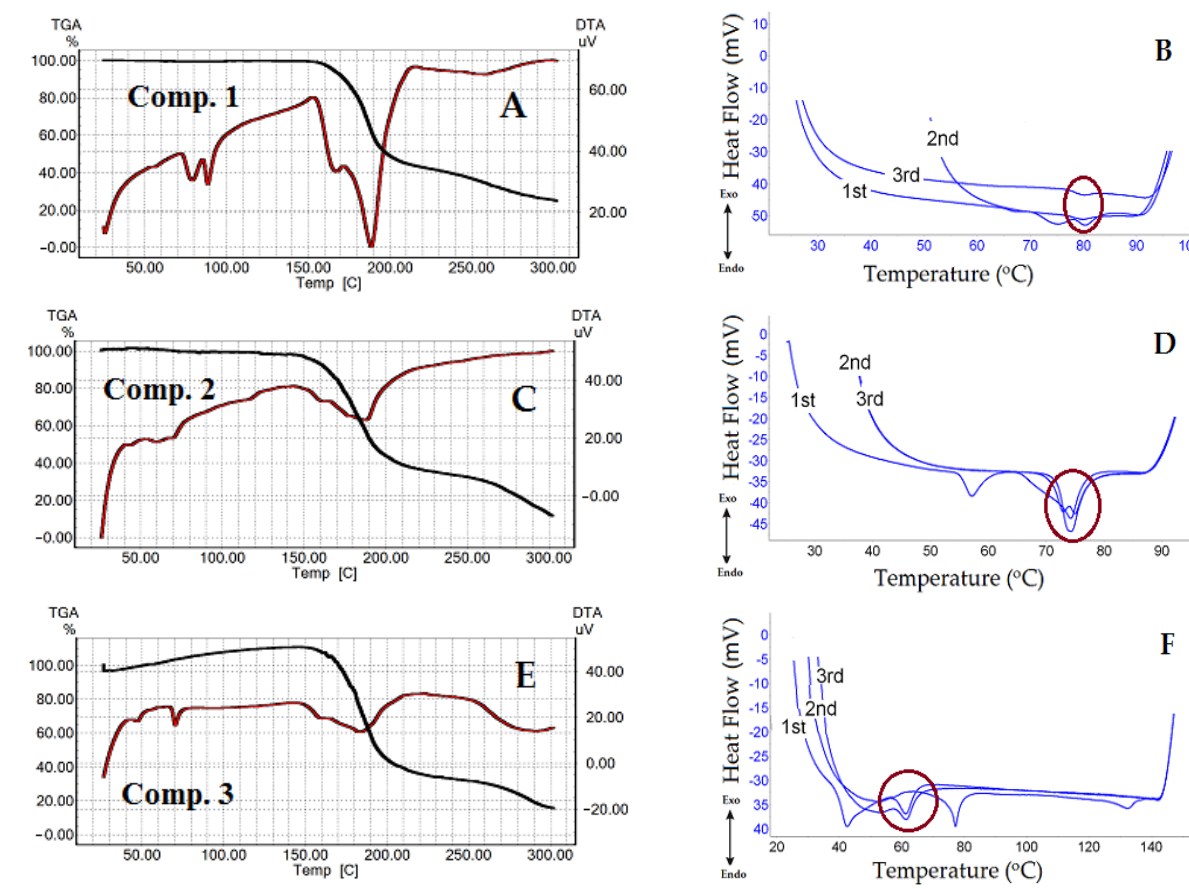
Figure 3. ( A , C , E ): TGA/DTA curves for comps. 1 – 3 . ( B , D , F ): DSC triple heating curves of comps. 1 – 3 in the temperature ranges before compound decomposition. The circles show endothermic peaks reproduced during the three heating cycles.